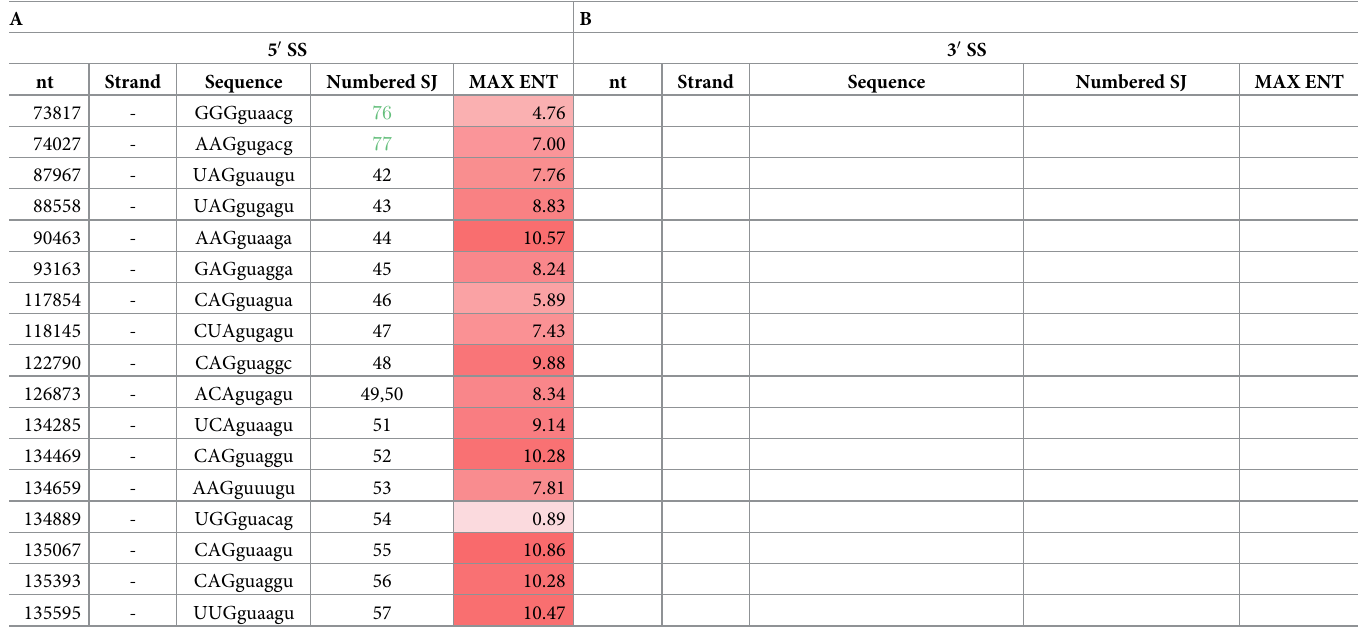
viral lncRNA PAN (SJ-58 and -59) and antisense RNA to ORF43 (SJ-60), antisense RNA to K11 (SJ-64 and -65), ORF49 (SJ-74), and antisense RNA to ORF50 (SJ-75 to -77) ( Fig 6A ). These splice junction reads could be readily detected and verified by RT-PCR and sequencing ( Fig 6B ). It is worth noting that most of these RNA splice junctions could also be detected from the WT genome with less than 10 splice junction reads ( S2B Fig and Table 3 ), but the SJ-68 was found only from the 57KO genome. Although detected in the expression of both 57KO and WT genomes, the spliced PAN RNA was just a tiny fraction among the abundant PAN transcripts. We identified total 54 RNA splice junction reads in the WT cells out of total 3,307,738 reads mapped to the PAN locus ( S1 and S2 Tables ). Similarly, we identified total 86 splice junction reads out of total 2,057,347 reads mapped to PAN in the 57KO cells. Thus, the splice junction reads from the PAN region represent only 0.0016% of the WT and 0.0042% of the 57KO total PAN reads. Nevertheless, these data indicate that loss of ORF57 expression led to alternative splicing of KSHV RNAs by activation of cryptic splice site usage in the intron-containing and/ or intronless viral transcripts. We previously identified ORF57 protein as a viral splicing factor promoting splicing of K8 intron 2 to express functional K8 α [17] by interaction with host splicing factor SRSF3 to atten- uate its suppressive activity on K8 intron 2 splicing [18]. Surprisingly, we did not observe an obvious retention of K8 intron 2 from the 57KO genome over the WT genome ( Fig 3 and Table 1 ). Although the cause of this discrepancy remains to be understood, we were assuming that the remaining expression of PAN RNA from the 57KO genome might compensate ORF57 loss by sponging SRSF3 in the 57KO cells. As expected, we found that overexpression of PAN RNA could promote K8 intron 2 splicing in HEK293T cells ( S3A Fig ). Additional reduction of SRSF3 RNA and protein levels due to virus-host shut off during lytic replication ( S3B Fig ) may further reduce the dependence of K8 splicing on ORF57, especially in the later stage of KSHV